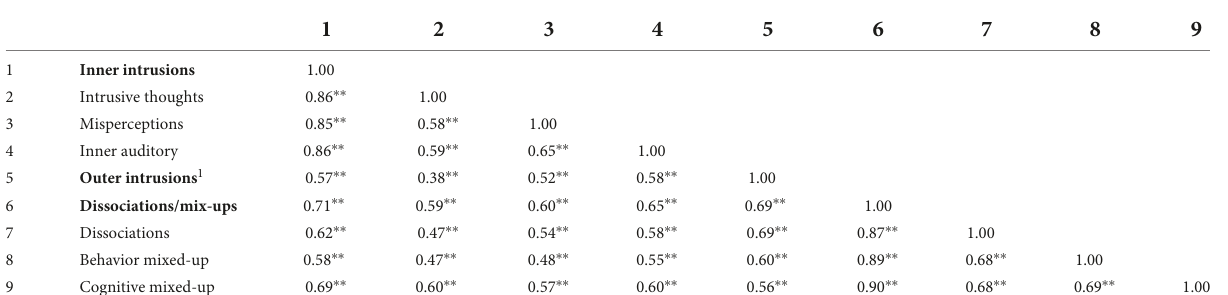
TABLE 7 Correlations between the dimensions of